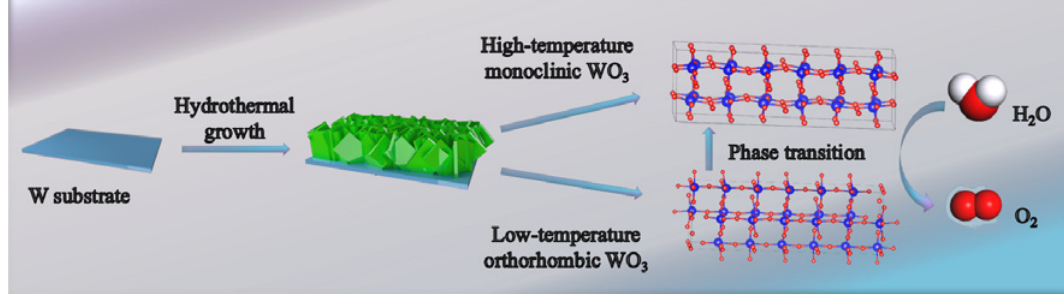
Fig. 1 Diagram of the preparation for WO 3 samples. Blue balls are W atoms, and red balls are O